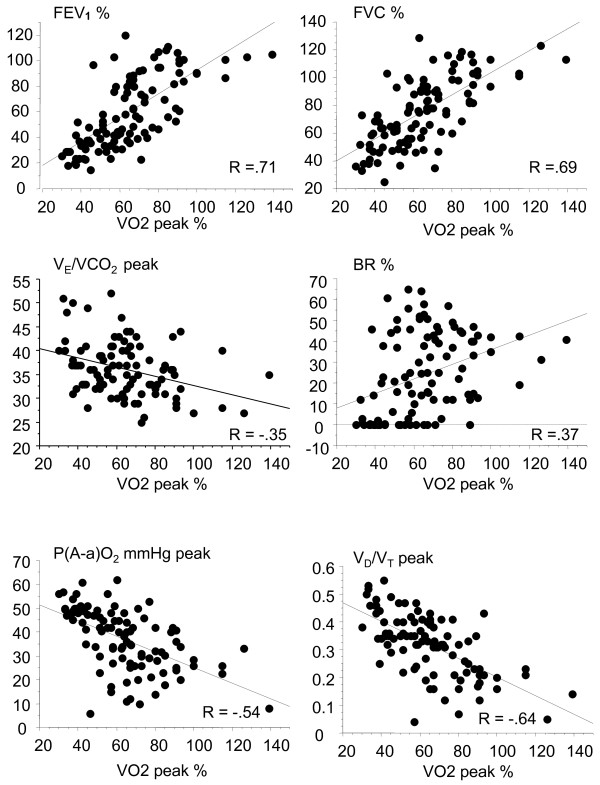
Correlation between VO2 peak and FEV1, FVC, VE/CO2 peak, BR, P(A-a)O2 peak, and VD/VT peak in CF patients. VO2 peak, FEV1, FVC, and BR are expressed as percentage of predicted values. P(A-a)O2 peak is expressed as mm Hg.